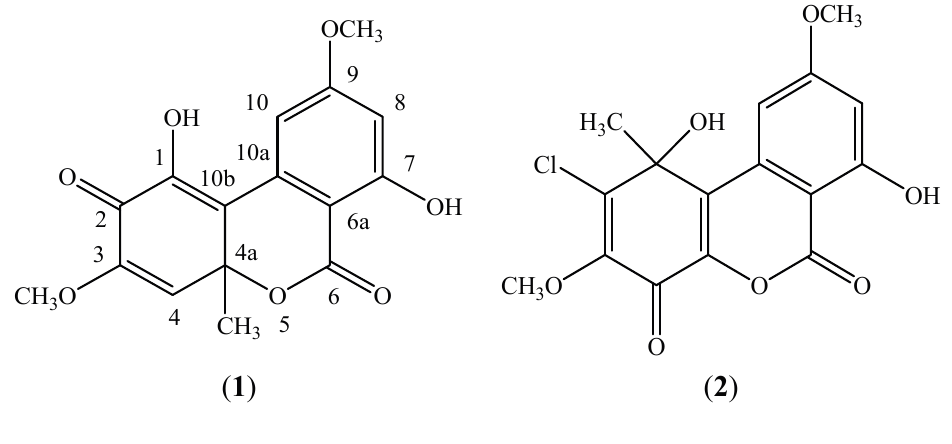
Figure 4. The structures of botrallin ( 1 ) and TMC-264 ( 2